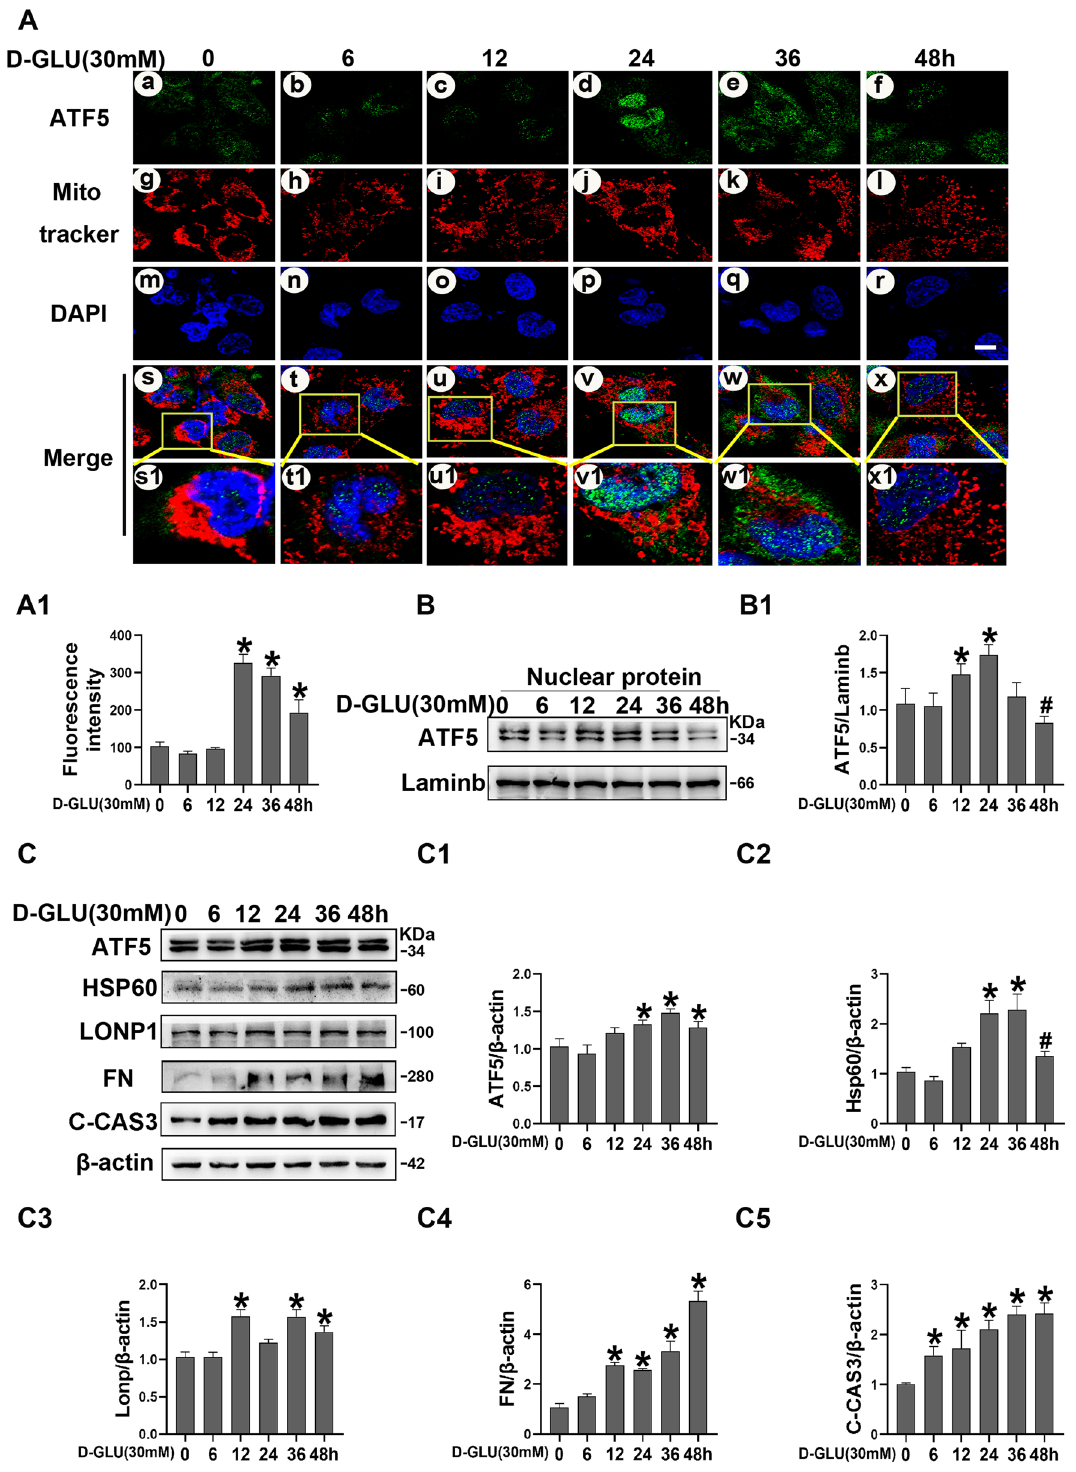
Fig. 5 ATF5 and UPRmt related molecule expression in HK-2 cells incubated with HG for 0–48 h. A Immunofluorescence analysis were performed to access ATF5 nuclear translocation in HK-2 cells. Scale bar: 2 μm. A1 Semiquantification of green fluorescence density of ATF5. B Western blot analysis of ATF5 nuclear protein expression in HK-2 cells. B1 Relative band density of ATF5. C Western blot analysis of ATF5, HSP60, LONP1, FN, C-CAS3 expression in HK-2 cells with 30 mM HG exposure for 0–48 h. C1–C5 Relative band density. All data are presented as means vs LG; # p < 0.05 vs 36 h HG. n =